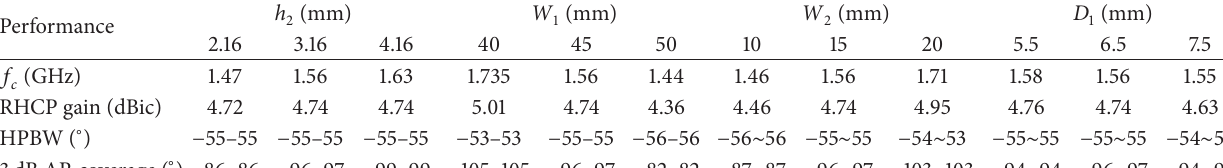
Table 2: The effects of parameters h Performance